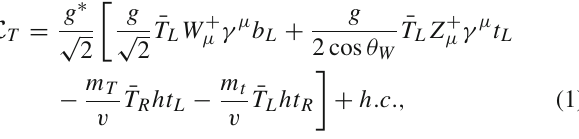
quark. g is the SU ( 2 ) L gauge coupling constant, v (cid:5) 246 GeV and θ W is the Weinberg angle. Thus there are only two model parameters: the top-partner mass m T and the coupling strength to SM quarks in units of standard couplings, g ∗